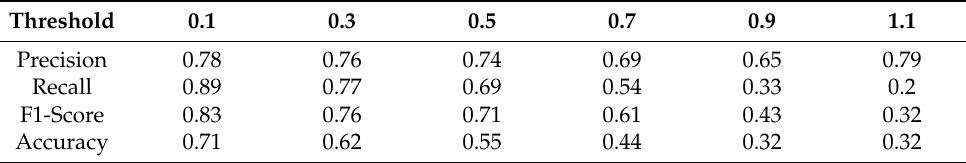
Table 2. Signal Difference Thresholds and Their Metrics.